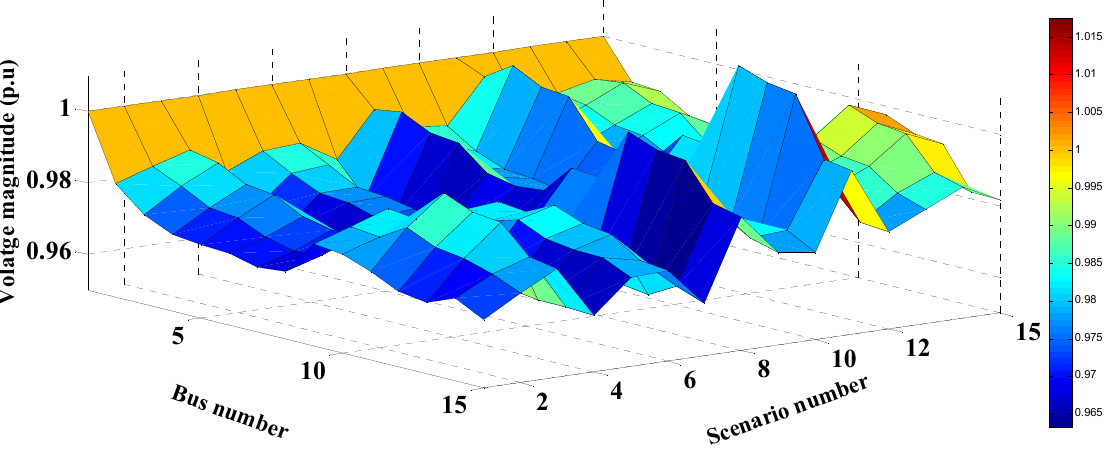
Figure 24. Bus voltage magnitudes of the 15-bus system without RERs.